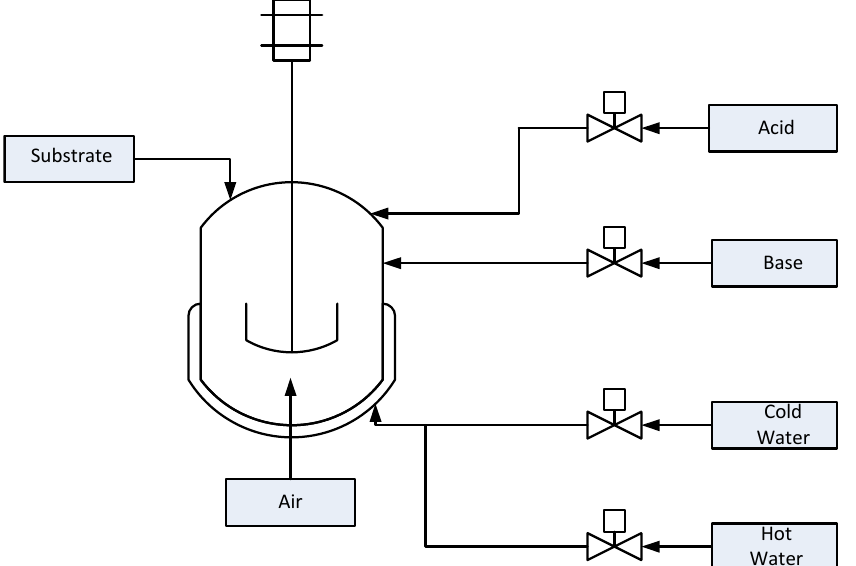
Figure 8. Schematic of the the PenSim process, reproduced with permission from [34]. Copyright Elsevier,